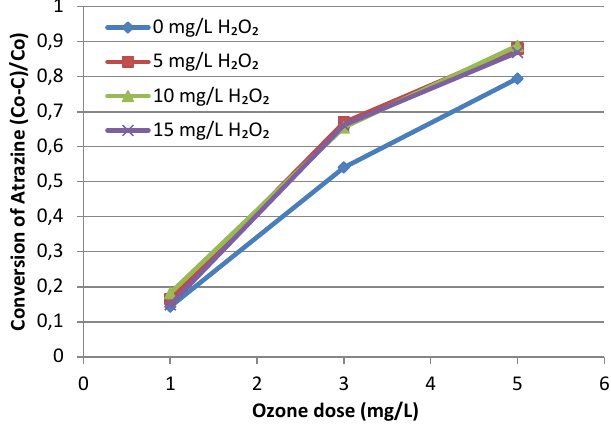
159mgL − 1 , DOC 3,26mg 3